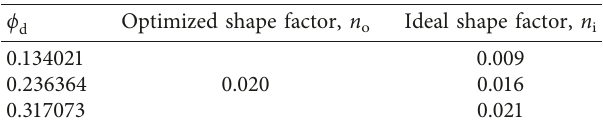
Table 5: Values of ideal shape factor at different SAPO-34 loadings of IL3M-emim[Tf 2